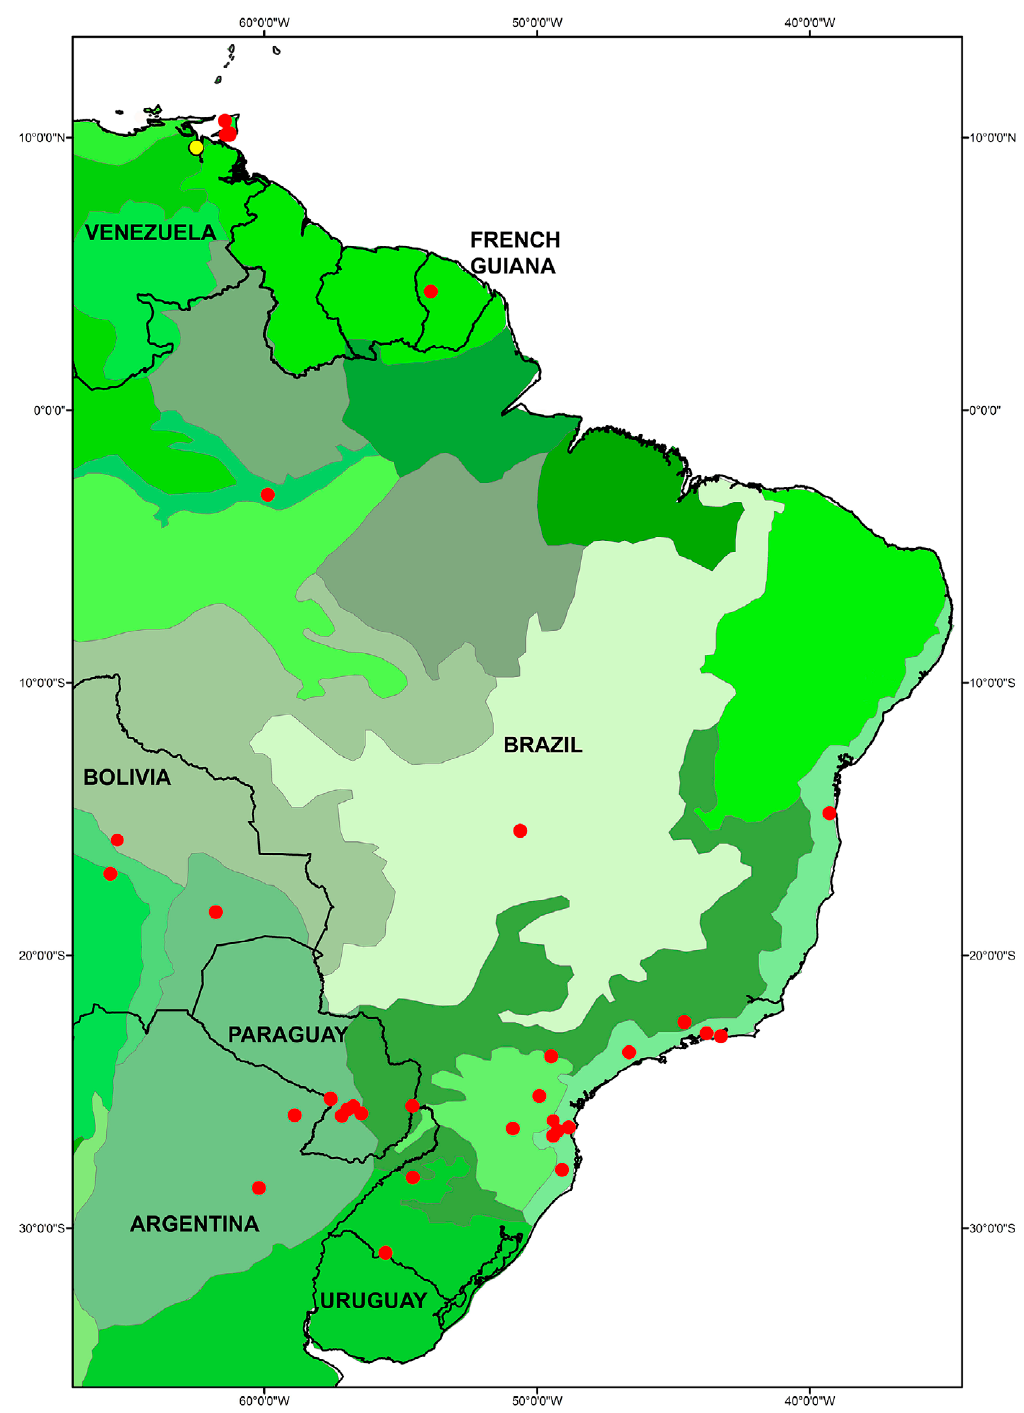
Figure 9. Map (based on Morrone 2014) of a section of South America, showing the distribution of Synpalamides phalaris (Fabricius) in South America. Every red dot corresponds to detailed site information data from specimens deposited in various insect collections worldwide or clearly designated localities found in literature. The yellow dot represents the detailed record (out of two) of S. phalaris from Venezuela and mentioned in this work. (Map elaborated by Bolívar R.